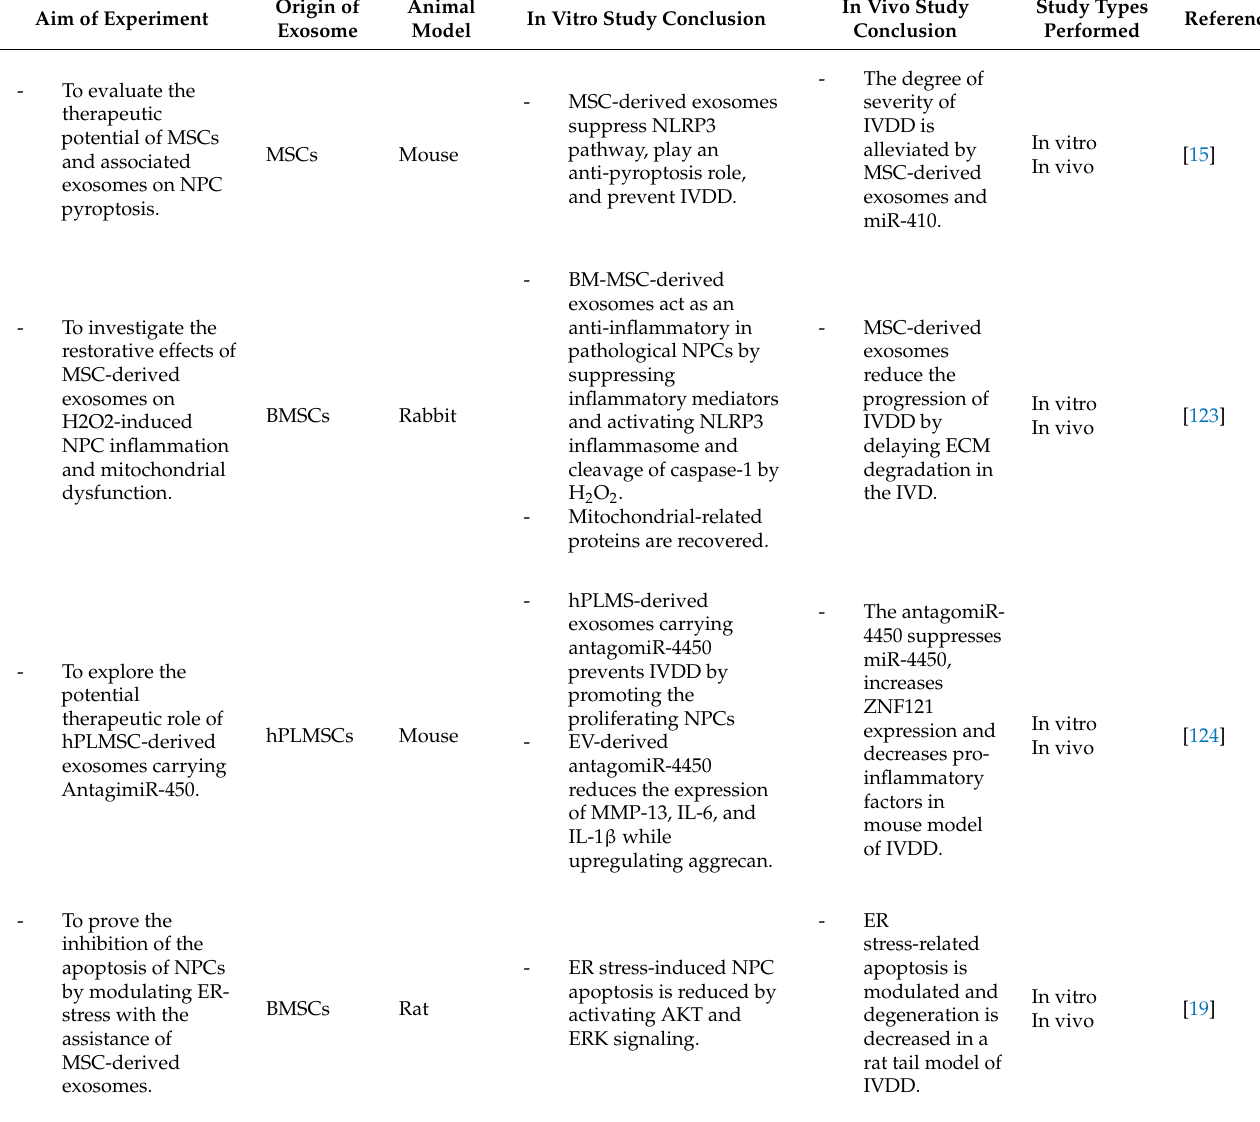
Table 3. Pre-clinical studies of stem-derived exosomes with their therapeutic potential for